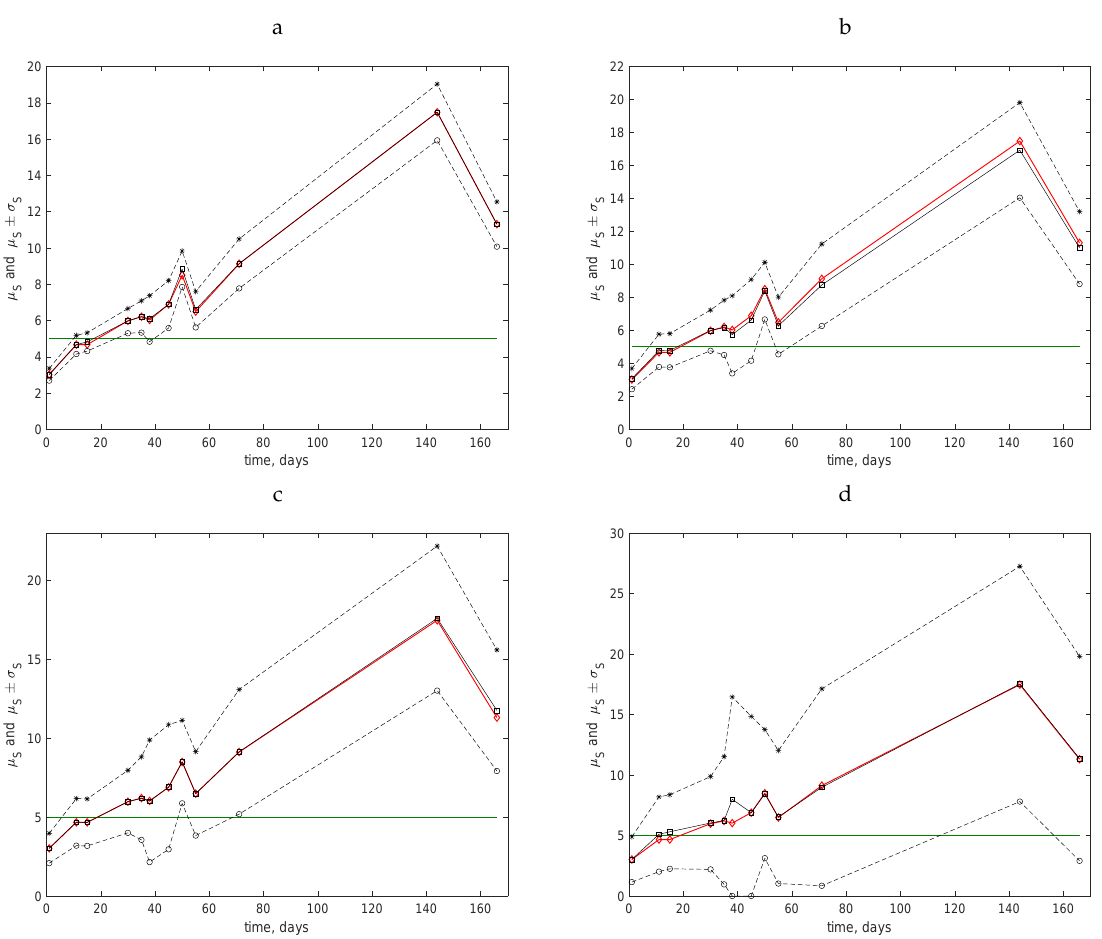
Figure 7. Temporal dynamics of slug populations in the Stoney Lawn field. Field assessments commenced on 7 December 2015 (Day 1). The mean value µ S (solid black line, open squares), the ‘exact’ value S of the average trap count calculated on the original grid of N = 100 locations (solid red line, open diamonds), the lower bound µ S − σ S (dashed line, open circles), and the upper bound µ S + σ S (dashed line, stars) of the range of the average trap count are shown. The hypothetical threshold value S T = 5 is shown by the horizontal solid green line. ( a ) Sampling grid of N = 25 locations. ( b ) Sampling grid of N = 9 locations. ( c ) Sampling grid of N = 4 locations. ( d ) Sampling grid of N = 1